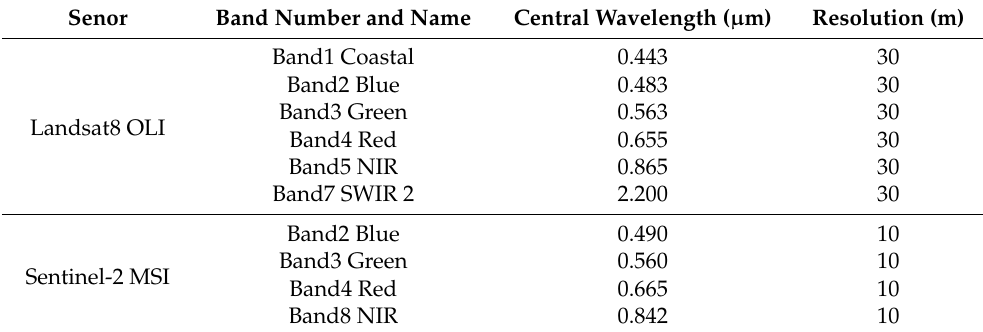
Table A2. The band parameter of Landsat 8 OLI and Sentinel-2 satellite remote sensing images used in this study .